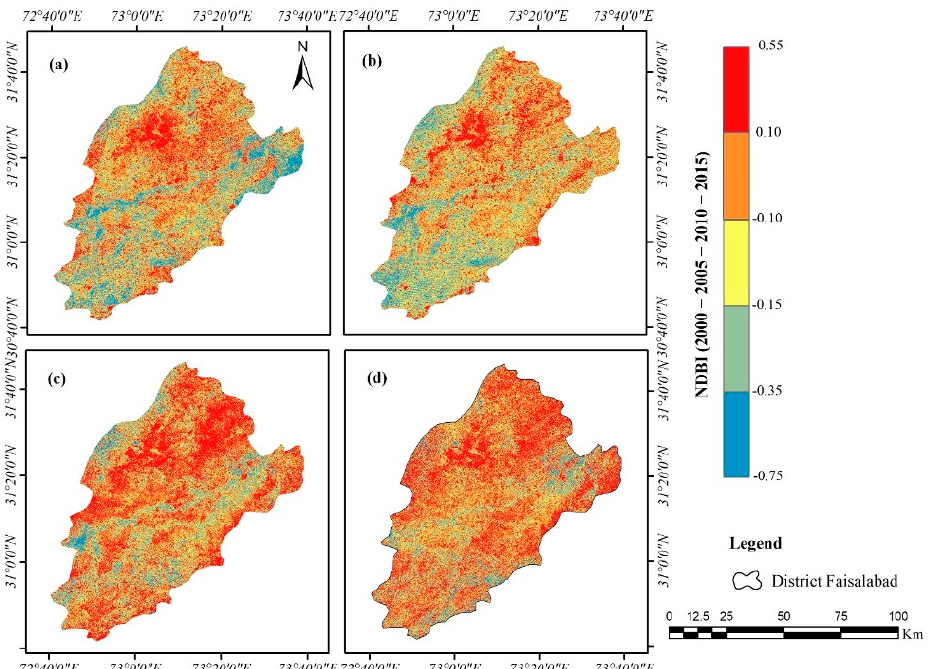
Figure 3. Spatial patterns of normalized difference built-up index averaged over 3 months (March– May), for 2000 ( a ), 2005 ( b ), 2010 ( c ), and 2015 ( d ).